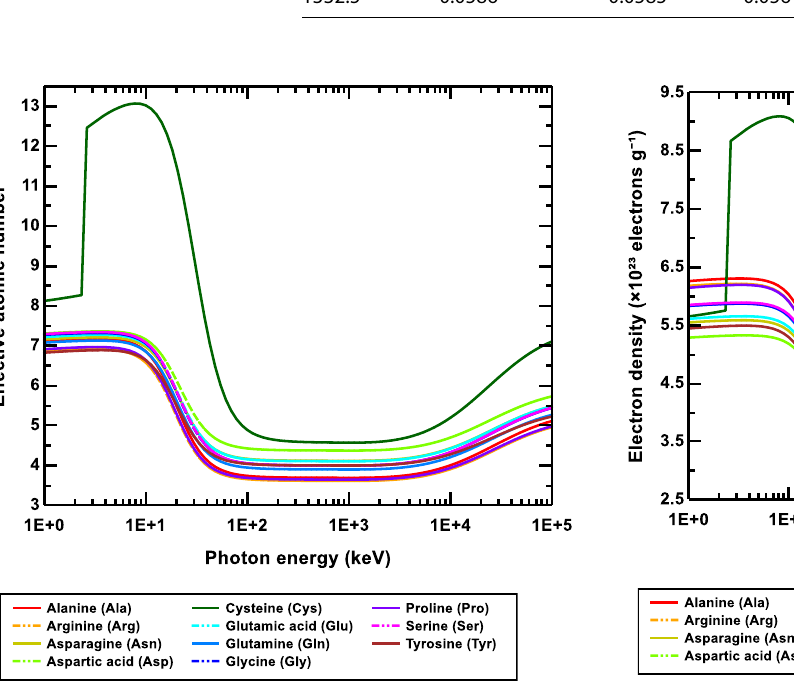
Fig. 2 Effective atomic numbers of NEAAs using EPICS2017 Fig. 3 Electron densities of NEAAs using